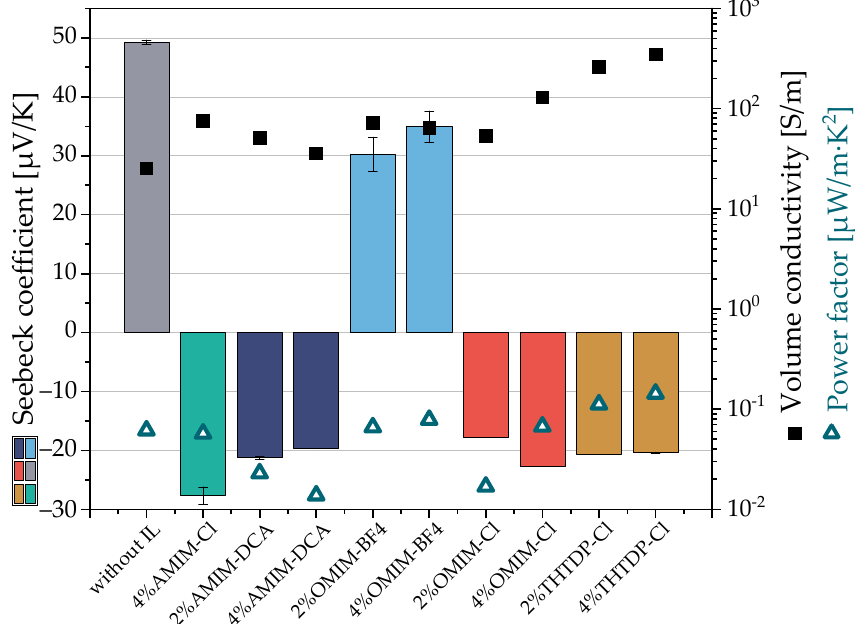
Figure 9. Seebeck coefficient, volume conductivity and power factor of PP/2 wt.% SWCNT composites with five different kinds of IL at 40 °C. Table 4. Thermoelectric parameters at 40 °C of the PP/2 wt.% SWCNT composites mixed with different ILs shown in Figure 9.